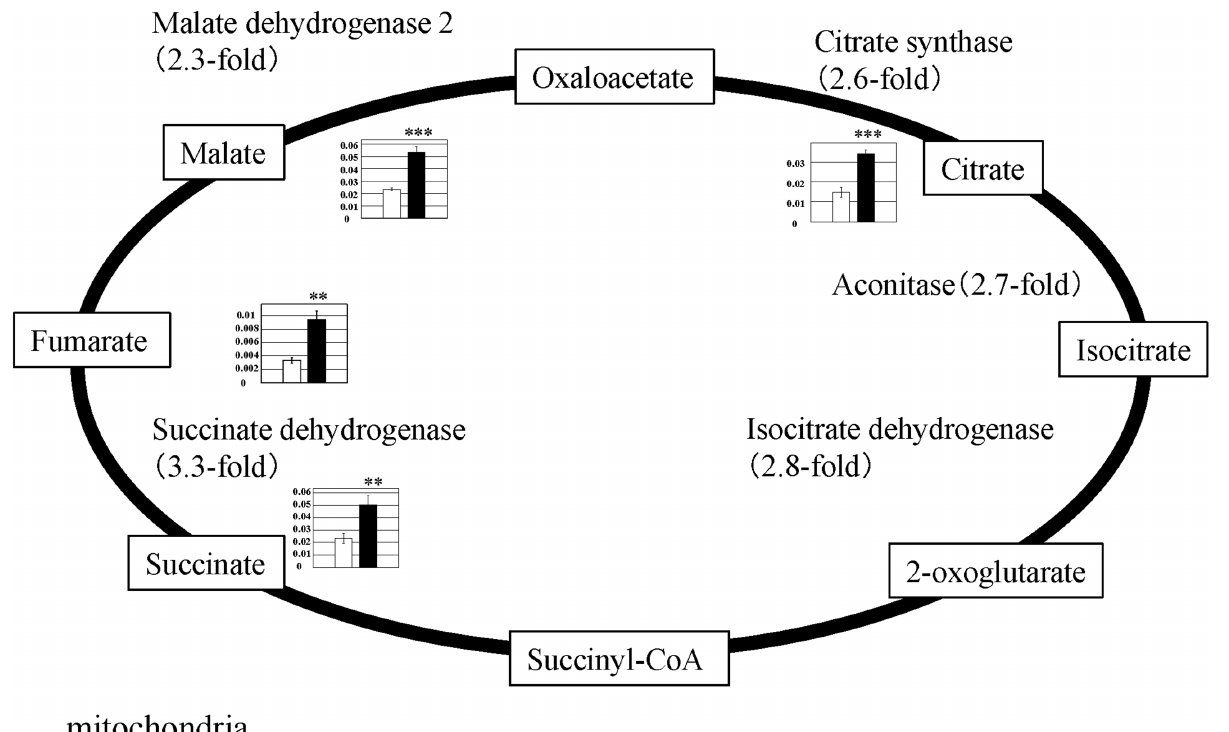
Fig 3. Observed metabolite changes mapped onto the pathways involved in the TCA cycle. Changes in the metabolite levels in the skeletal muscle of PGC-1 α -Tg mice and WT mice are shown. Relative metabolite changes shown in the graphs were obtained by CE-TOFMS (S1 Table). Open bars, WT and filled bars, PGC-1 α -Tg (N = 3). Data are expressed as the mean ± SD. Asterisks indicate statistically significant differences ( *** p < 0.001, ** p < 0.01). Microarray data of gene expression change of enzymes in the related metabolic process are shown in the